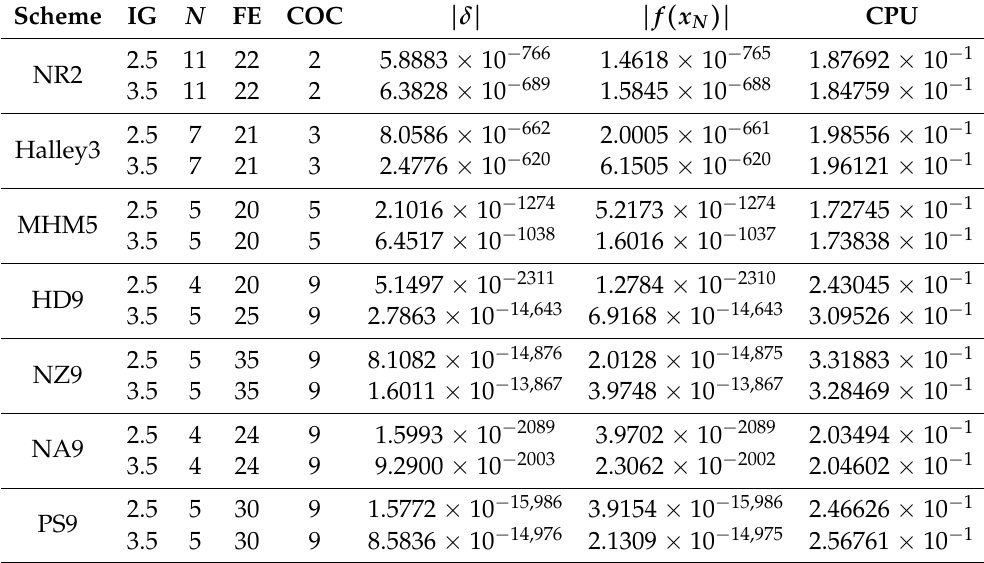
Table 4. Numerical results for problem 2 ( f 2 ( x )) with two different initial guesses.